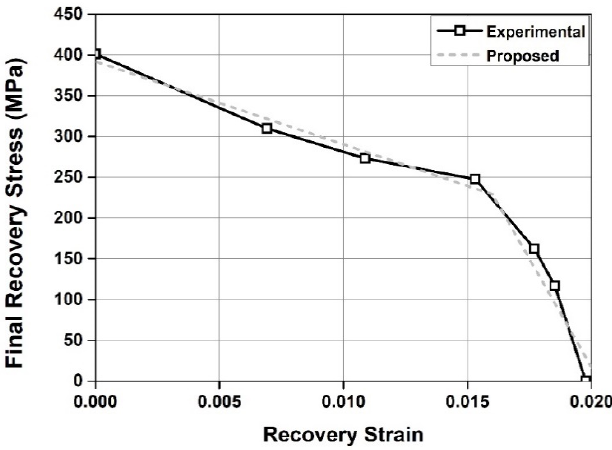
Figure 15. Pipe joining process by Fe ‐ SMA coupler.